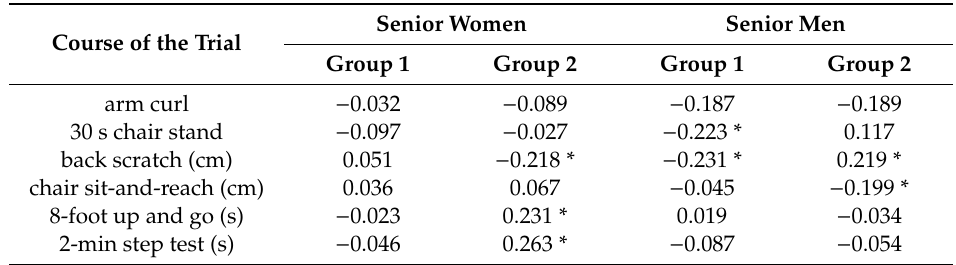
Table 7. Pearson correlation coe ffi cient for the functional fitness levels and the age of the older adults